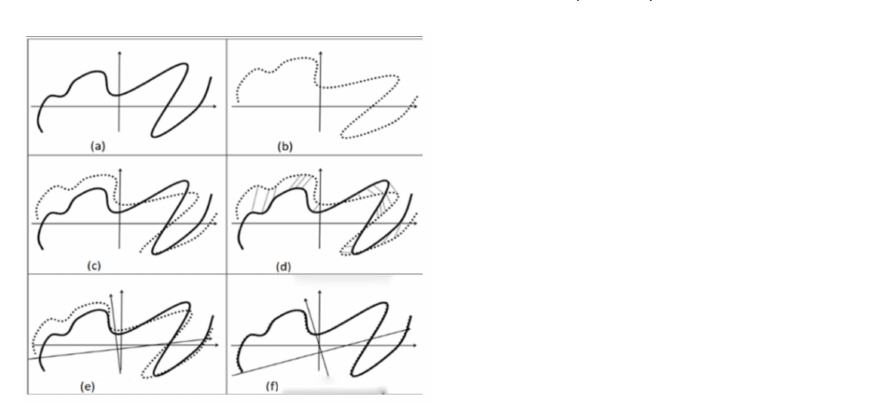
Figure 3. The principle of ICP algorithm. ( a ) Frame i ( b ) Frame i + 1 ( c ) Start matching ( d ) Find adjacent ( e ) First match ( f ) After multiple iterations of